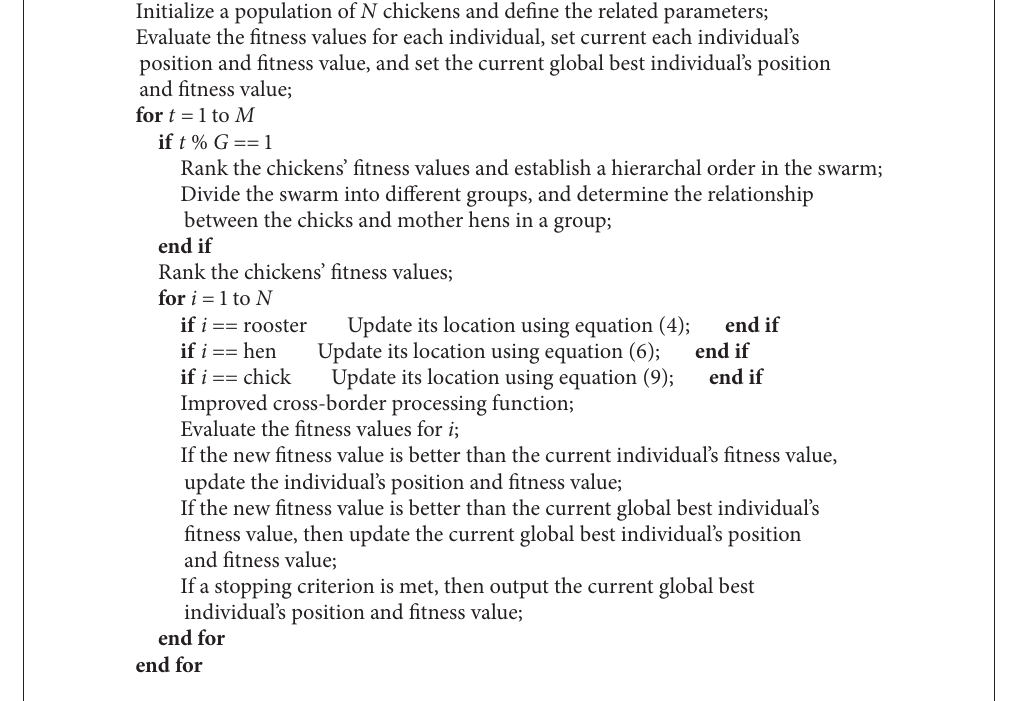
Algorithm 3: Improved boundary chicken swarm optimization.